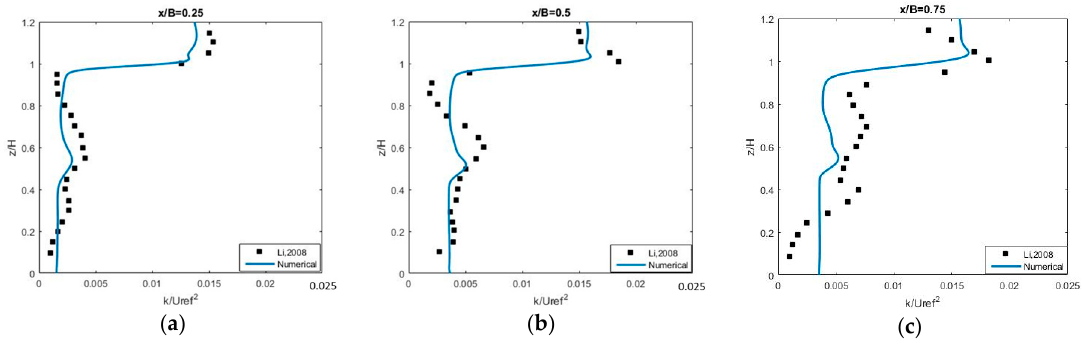
Figure 8. Turbulence kinetic energy at x/H = 0.25 ( a ), x/H = 0.5 ( b ) and x/H = 0.75 ( c ) with AR = 2.